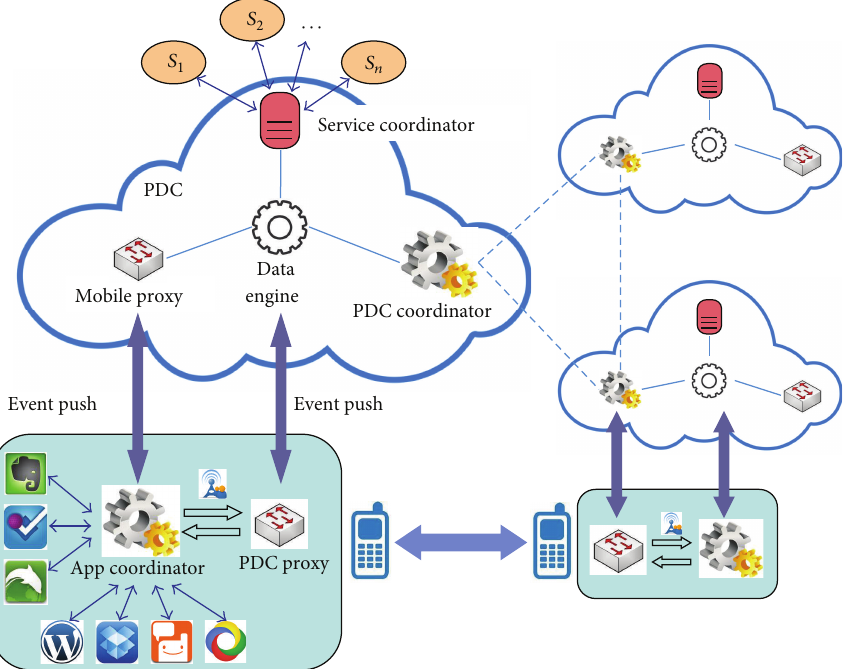
Figure 5: PDC-based adaptive service